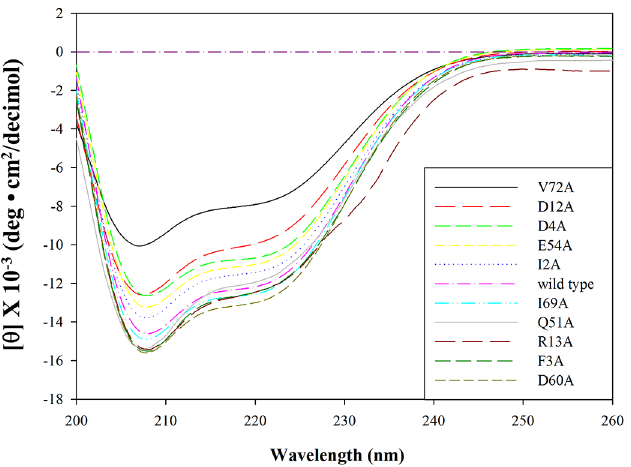
Fig 2. Circular dichroism spectra of wild-type and alanine-substituted rSco-CHH-Gly. CD spectral data of each recombinant peptide, dissolved in 10 mM PBS (150 mM NaCl, pH 6.8), were collected from 260 nm to 200 nm at 25°C using an AVIV 202